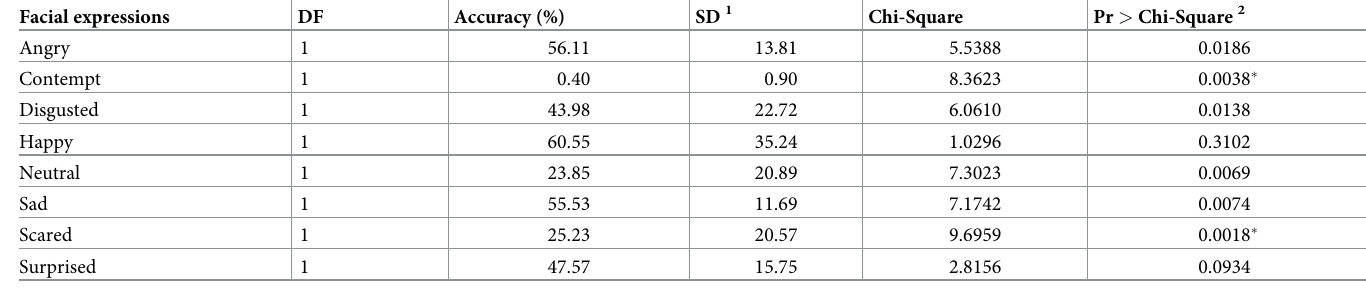
Table 2. Accuracy of eight facial expressions using FireFACE software and repeated Kruskal-Wallis tests on the difference from records in documented studies that are shown in Table 1. Facial expressions